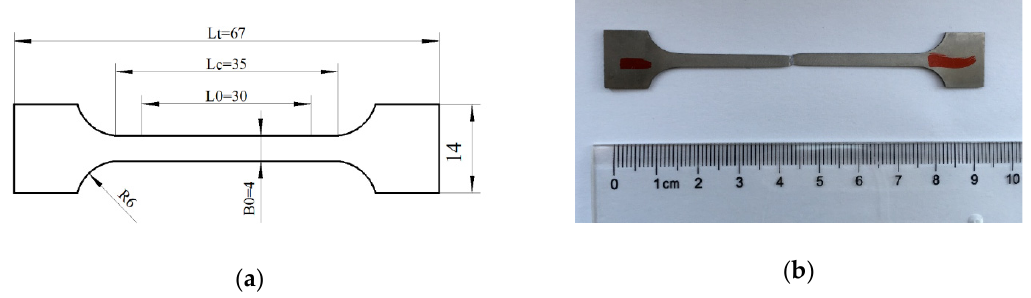
Figure 1. Tensile test sample of the GH1140 superalloy: ( a ) the tensile test sample structure; and ( b ) the stretched test